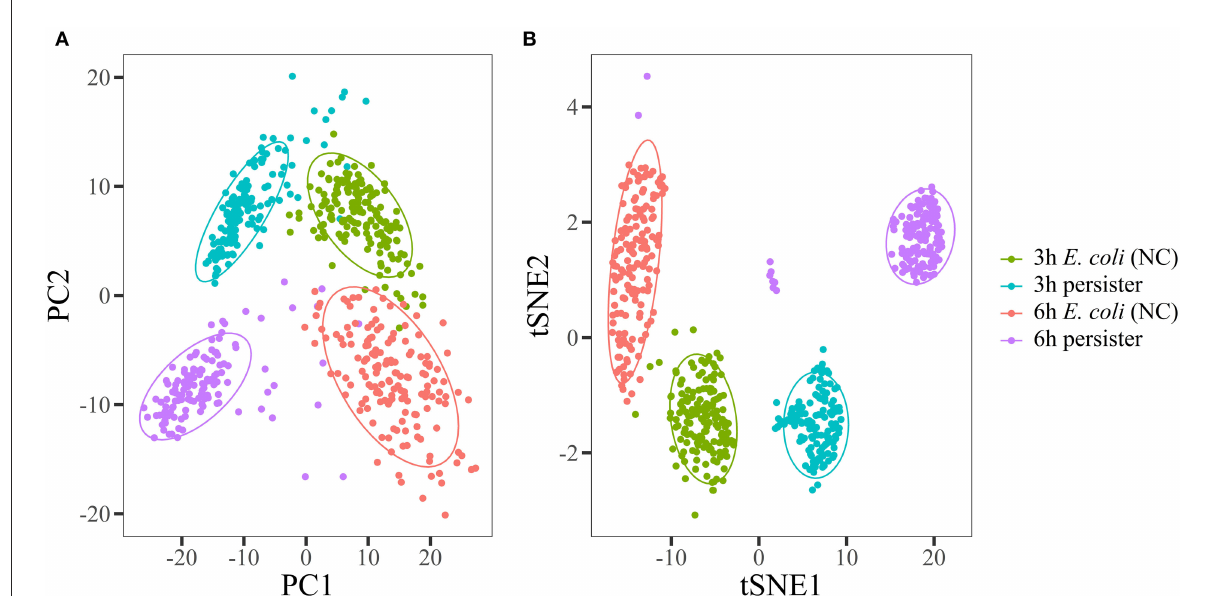
FIGURE2 Raman spectra of E. coli and its persisters displayed with unsupervised tagging machine learning methods. Overnight planktonic-cultured E. coli (12h) was 1:100 diluted into fresh LB broth and further cultured for 3 and 6h, followed by ampicillin treatment (100 µ g/mL, 32 × MIC) for 4h. Single-cell Raman spectra were acquired afterward. Principal component analysis (A) and t-distributed stochastic neighbor embedding (B) were used to visually display the data structure of Raman spectra. E. coli and its persister cells were classified into different projective zones using both methods. N > 50 for each group. NC: E. coli cells without ampicillin